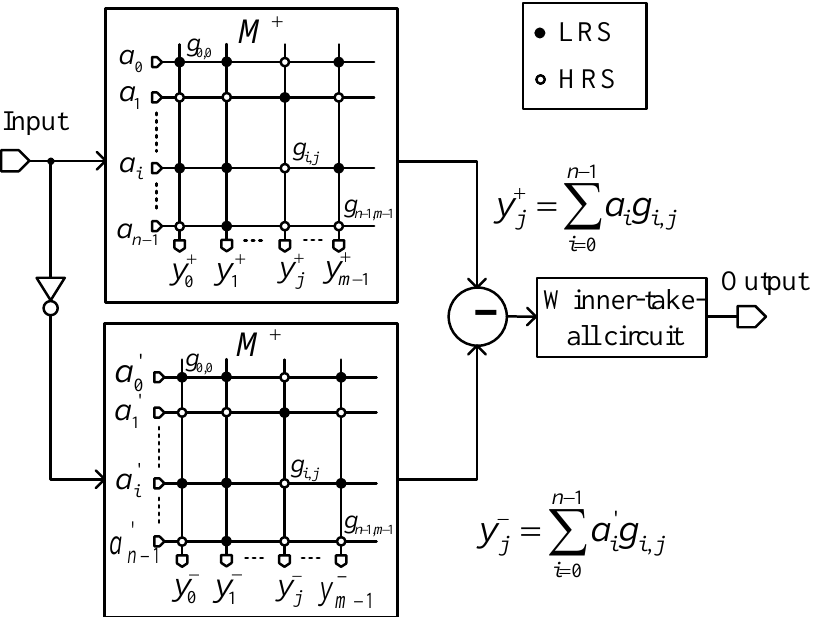
Figure 2. The twin crossbar architecture, which employs two identical crossbar arrays for image recognition (Reproduced with permission from [15], published by IEEE).